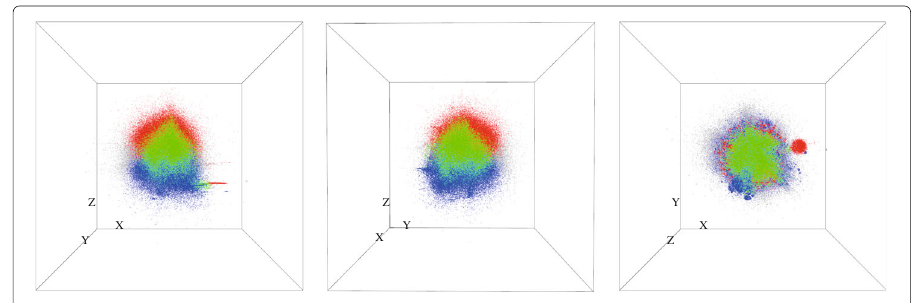
Fig. 7 Half-cut cross-sections of the 3D images of the TSR network as shown in Fig.